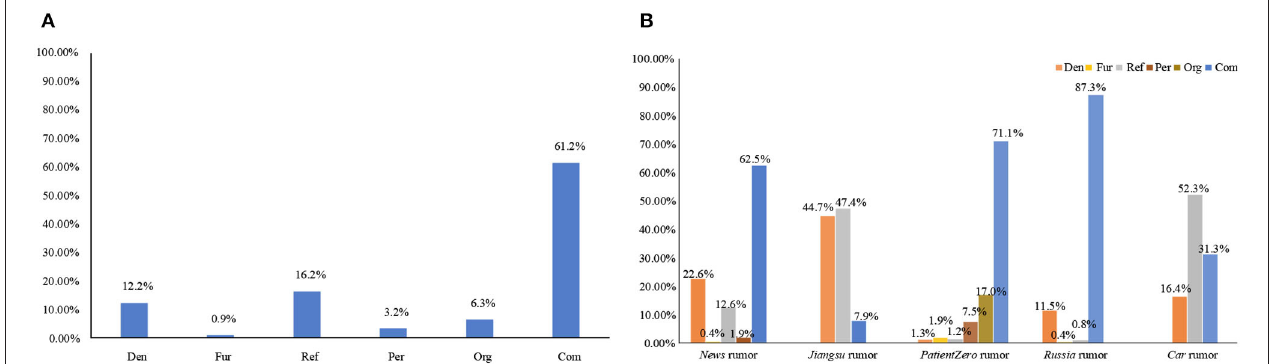
FIGURE 3 | Proportion of postings of the six debunking methods in the (A) overall and (B) each rumor. Den, Denial; Fur, Further fact-checking; Ref, Refutation; Per, Person response; Org, Organization response; Com, Combination.